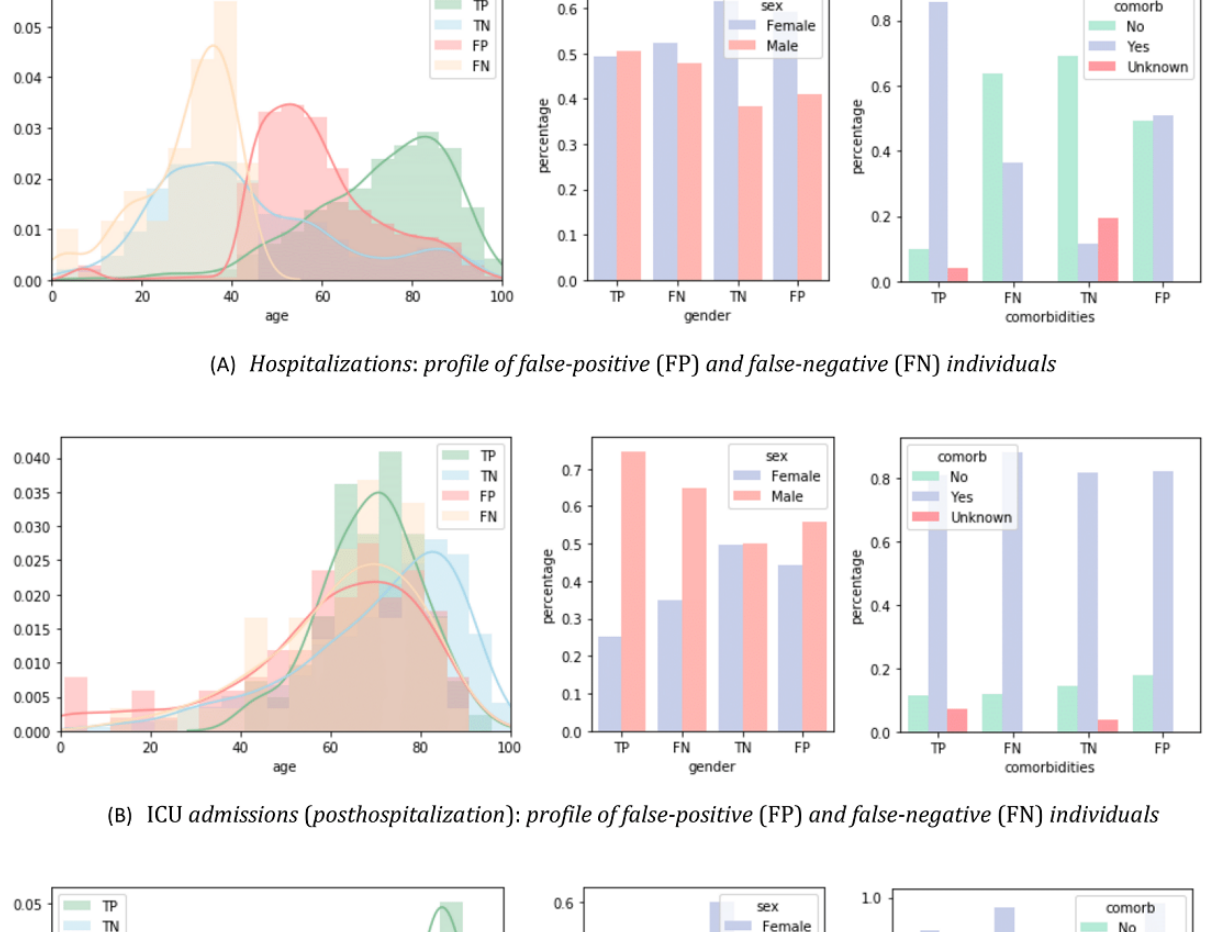
Figure 13. The characteristics of incorrectly predicted individuals with XGBoost. Particular attention should be paid to the differences between true-positive and false-negative individuals given their clinical relevance. ICU: intensive care